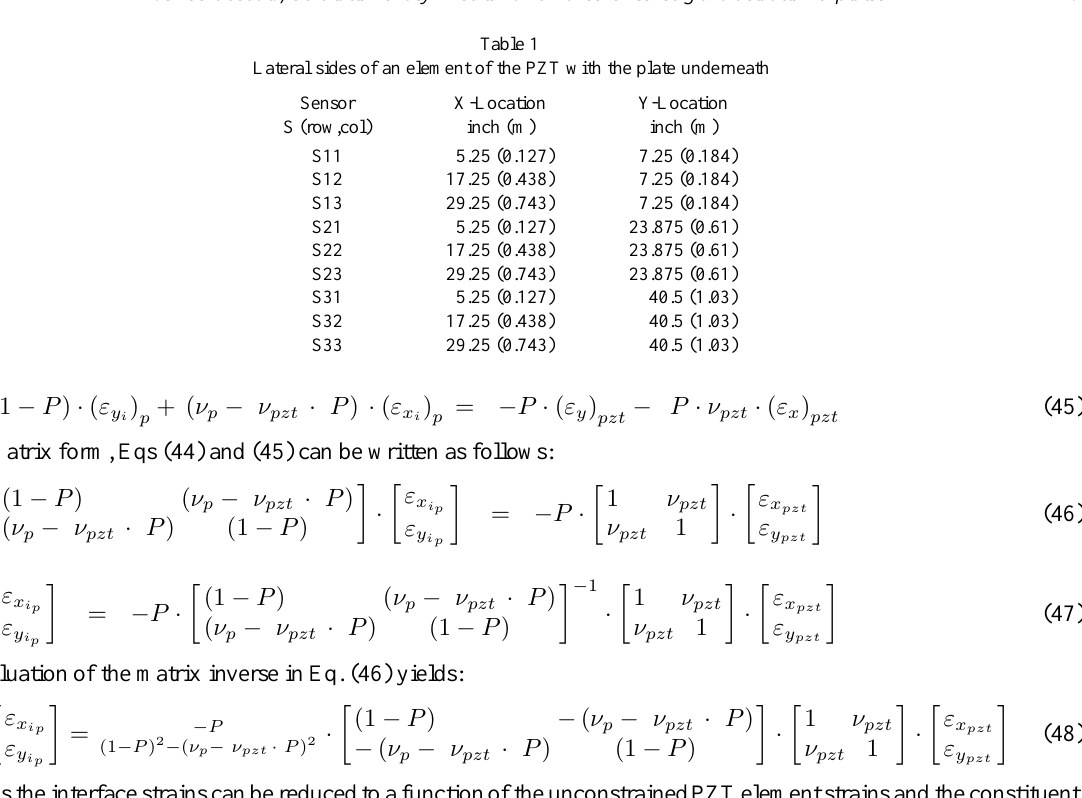
Table 1 Lateral sides of an element of the PZT with the plate